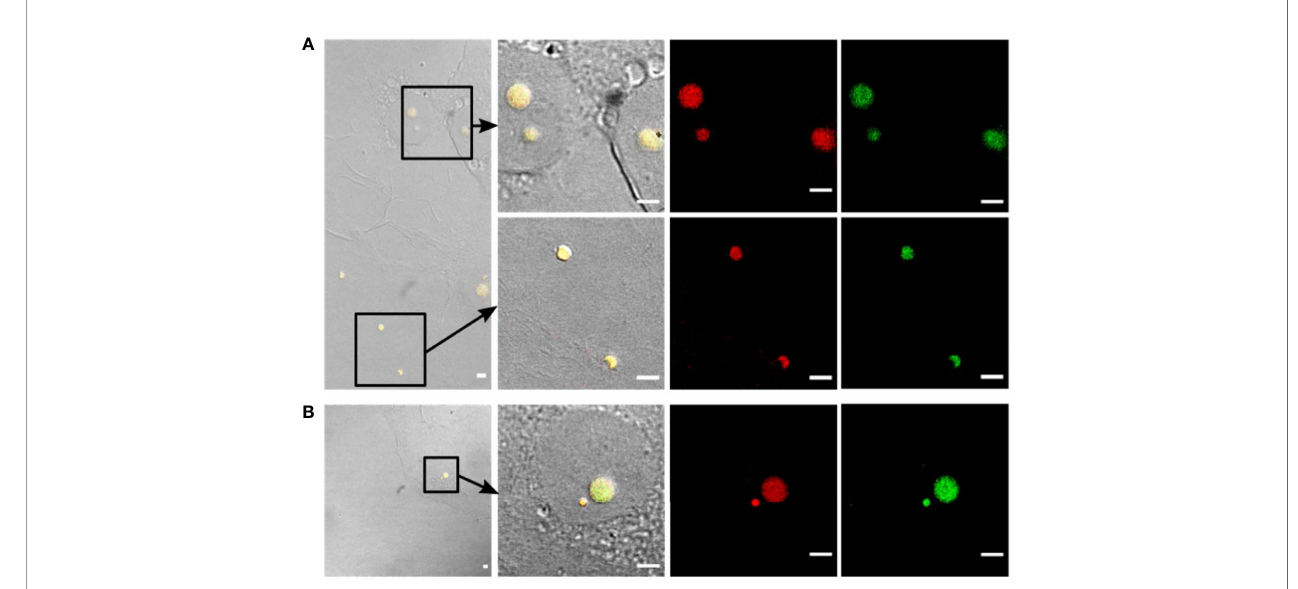
FIGURE 5 | Con fi rmation of intracellular presence of Listeria L-forms inBeWocellsby fl uorescence in-situ hybridization (FISH). (A) BeWo cells infectedwith Listeria monocytogenes revertant strain Rev10 and treated with 25 µg/ml Ampicillin. (B) BeWo cells infectedwith revertant strain Rev10 and treated with 50 µg/ml Ampicillin.Black squares in the DIC images (left) indicate the areaof magni fi cation. The fi rst two columnsrepresent a superimposition of DIC images (yellow fl uorescence) showing the green GFP- fl uorescence and the red signal from the Listeria genus-speci fi c probes Lis-637 and Lis-1255. Allstructures showinggreen GFP- fl uorescence hybridized inparallel with the Listeria genus-speci fi c probes (redsignals),thus con fi rmingthat the observed sphericalstructures are true Listeria L-forms. Scalebar = 10